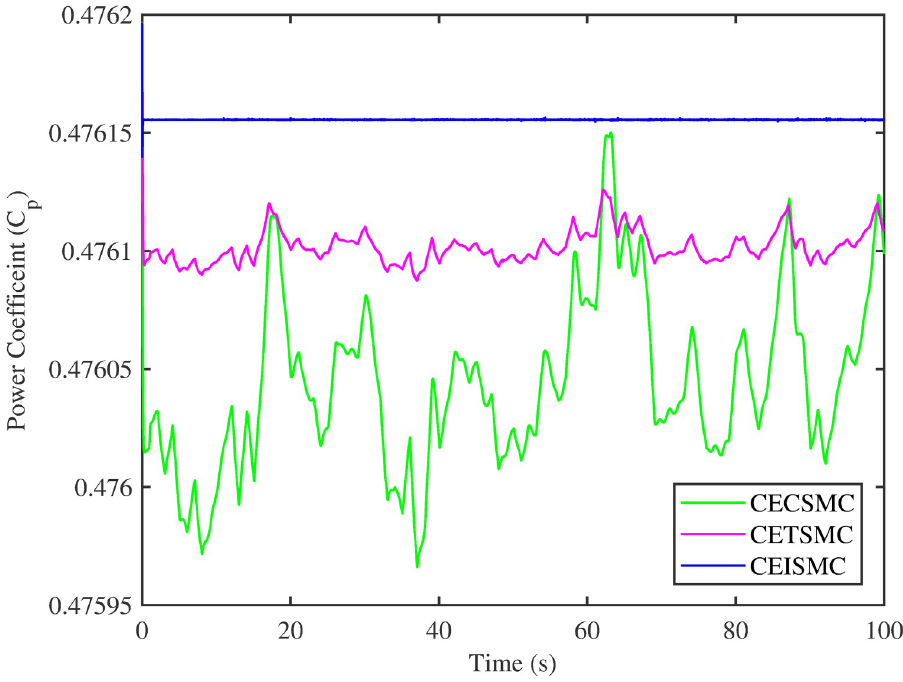
Fig 9. Power coefficient versus